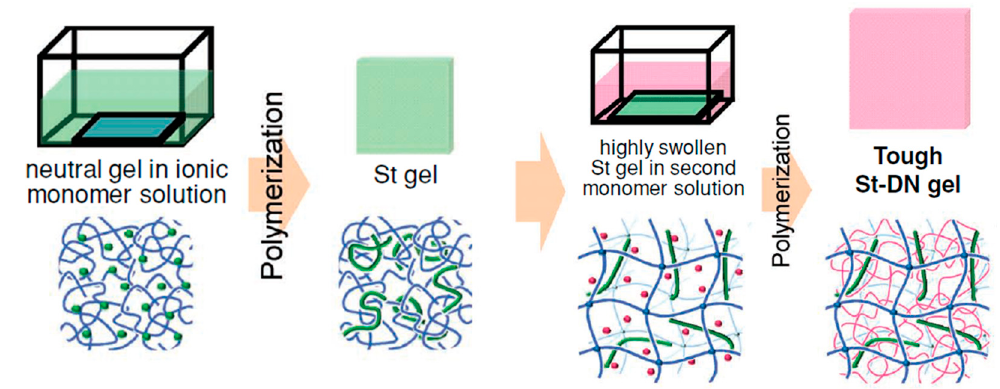
Schematic representation of the preparation of the triple-network (TN) hydrogels containing a polyelectrolyte molecular stent as the second component. After its preparation, the first nonionic polymer network was immersed in the ionic 2-acrylamido-2-methylpropane sulfonic acid (AMPS) monomer solution, and, after its equilibrium swelling, the resulting composite system was photopolymerized in order to obtain the double-network (DN) hydrogel. Then, the DN hydrogel was immersed in an aqueous solution of the second acrylamide (AAm) monomer, and this system was photopolymerized in order to obtain the TN hydrogel. Adapted and reprinted with permission from [21]. Copyright 2012 John Wiley & Sons, Inc.